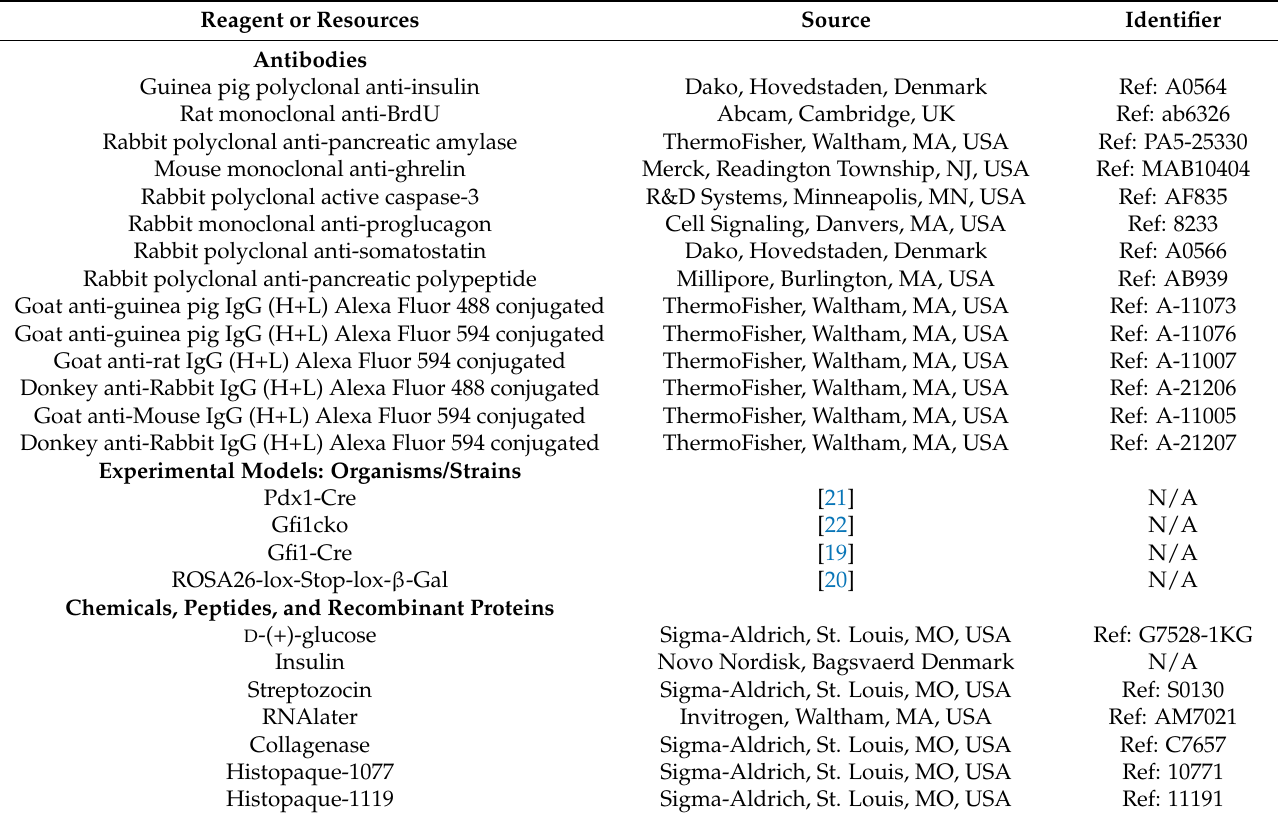
Table 1. Key reagents and